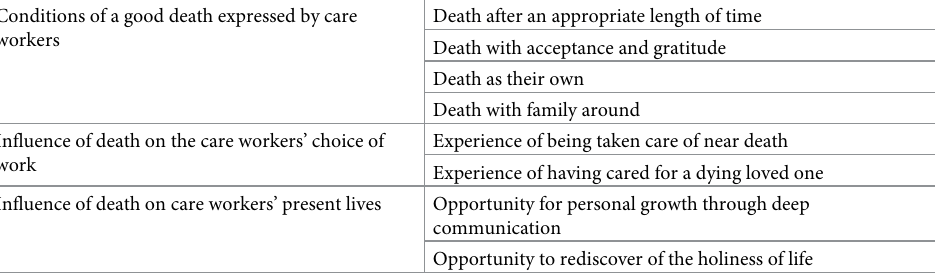
Table 4. Themes revealed in our interviews concerning care workers’ view of death. Conditions of a good death expressed by care workers Influence of death on the care workers’ choice of work Influence of death on care workers’ present lives Opportunity for personal growth through deep